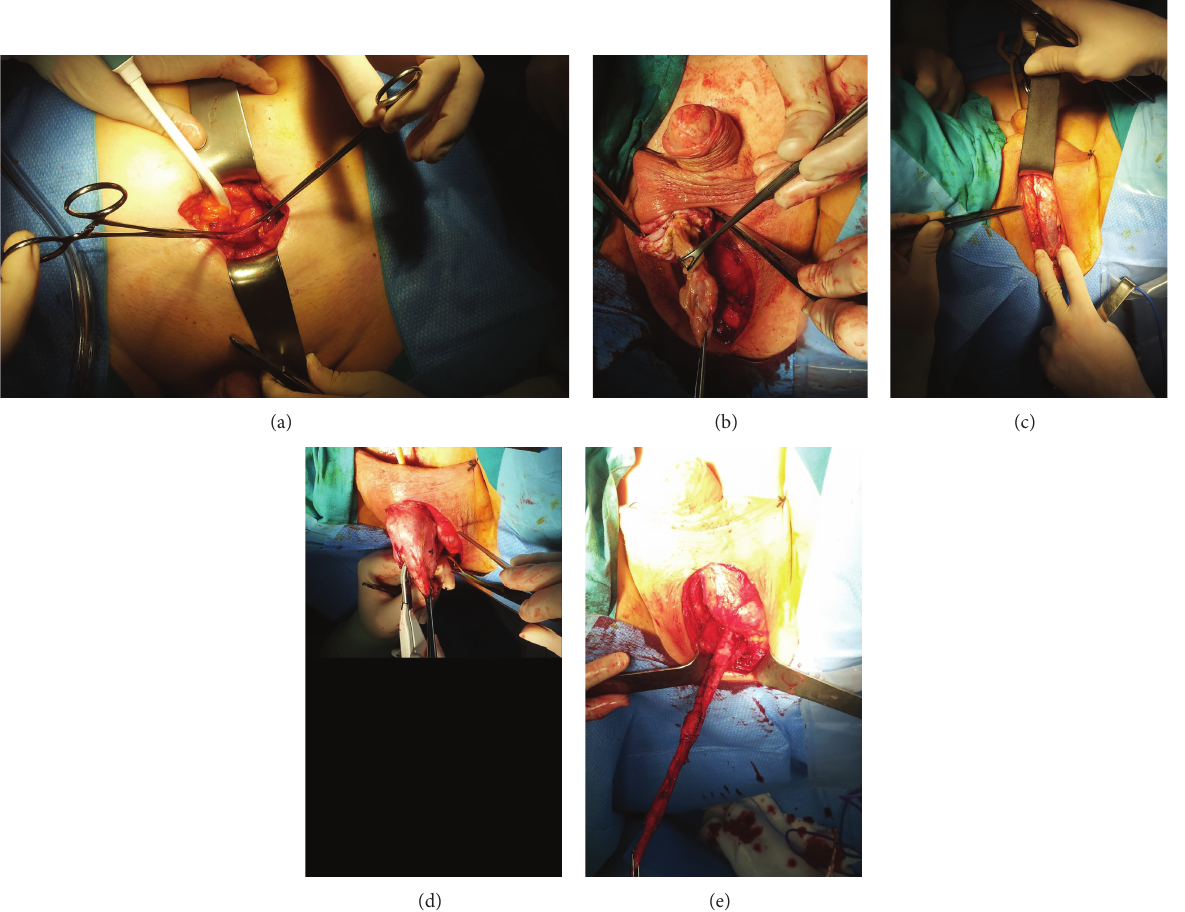
Figure 4: Final surgical step. From upper-left to lower-right: (a) performing vesicostomy; (b) subalbuginea orchiectomy; ((c), (d), and (e)) sequential steps of urethrectomy.